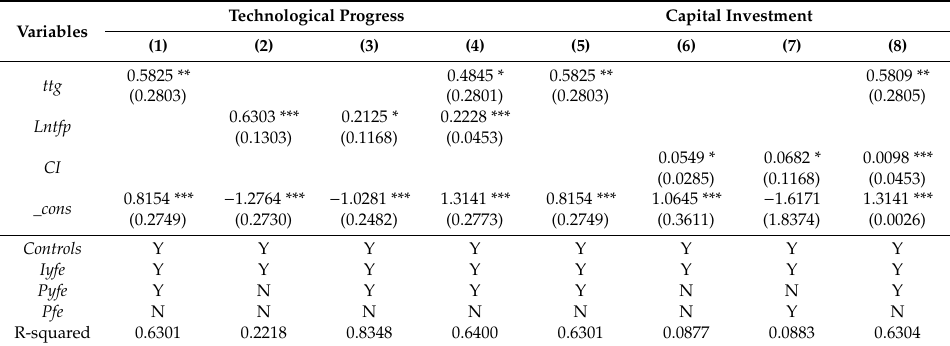
Table 5. Mediating e ff ect